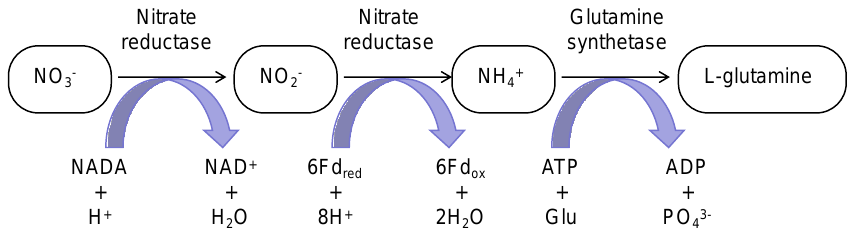
Figure 1. The process of N assimilation by MA.